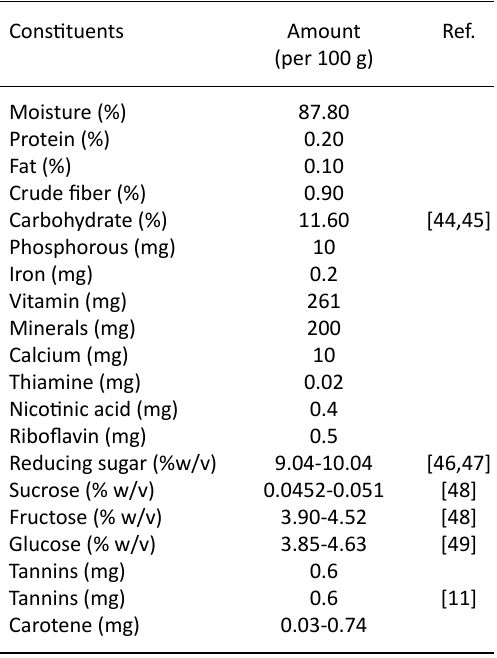
Table 1. Chemical and nutritional composition of the cashew